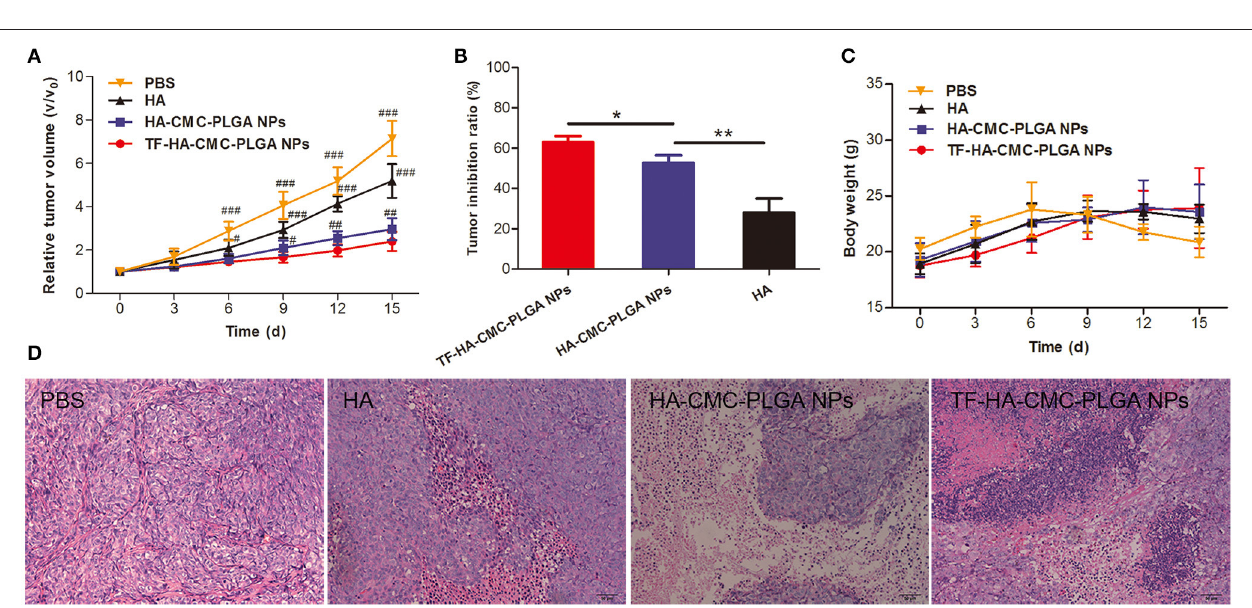
FIGURE 9 | In vivo PDT effect. (A) Relative tumor volume; (B) Tumor inhibition ratio; (C) Body weight; (D) H&E staining tumor tissue of A549 tumor-bearing mice after PDT treatment with PBS, HA, HA-CMC-PLGA NPs, and TF- HA-CMC-PLGA NPs (equivalent to about 0.05 µ M HA). Each data point (mean ± SD) was calculated for quintuplicate ( n = 5). The mice were exposed to 470nm LED (90 mW/cm 2 ) for 30min. # p < 0.05 vs. TF-HA-CMC-PLGA NPs; ## p < 0.01 vs. TF-HA-CMC-PLGA NPs; ### p < 0.001 vs. TF-HA-CMC-PLGA NPs. * p < 0.05; ** p < 0.01. Scale bar = 50 µ m.